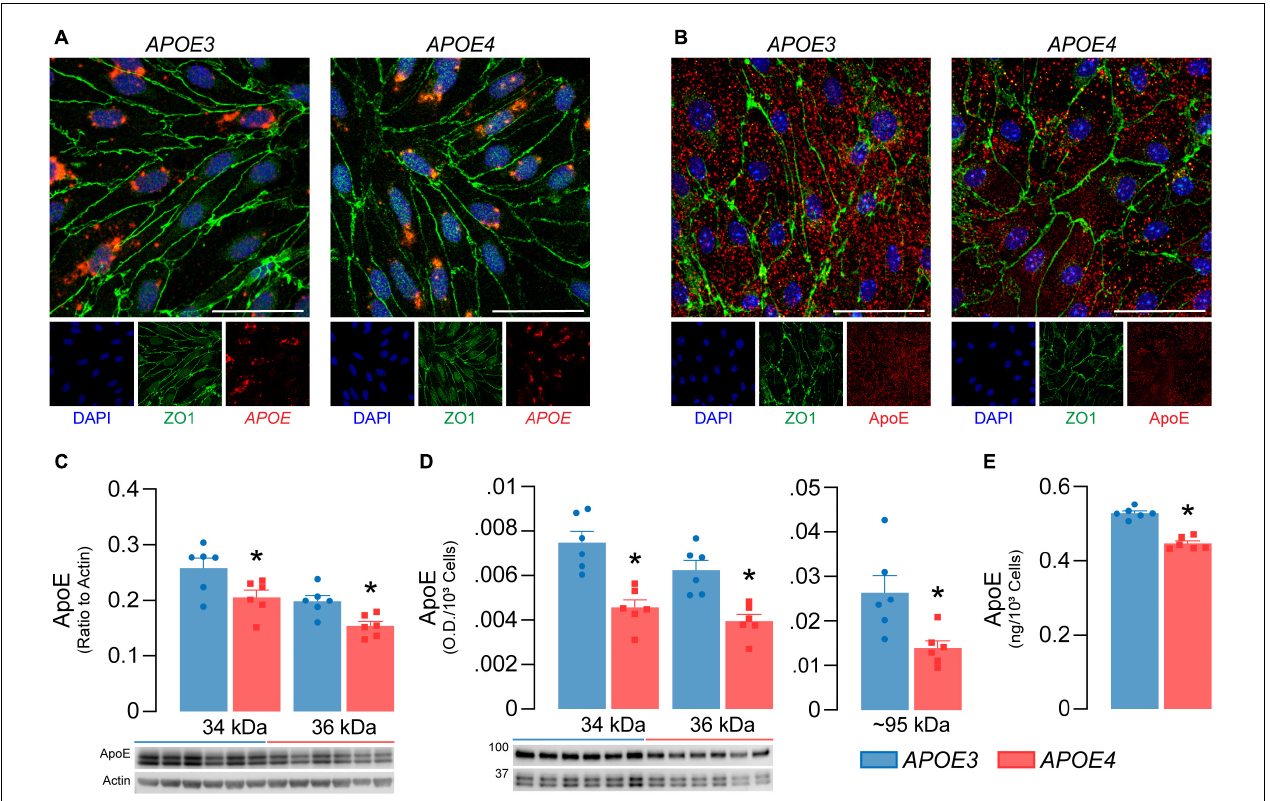
FIGURE 2 | APOE4 brain endothelial cells produce less apoE compared to APOE3 . APOE3 and APOE4 brain endothelial cells express (A) the APOE transcript (red) and (B) produce apoE protein (red) when assessed by in situ hybridization and immunocytochemistry, respectively. Cells were counterstained for the brain endothelial cell marker ZO1 (green) and DAPI (blue); representative confocal Z-stack images were captured at 52X (scale bar = 20 µ m). Both (C) cell-associated (lysate) and (D) secreted (conditioned media) apoE levels are lower with APOE4 when assessed by western blot analysis. Cell-associated apoE was normalized to actin as a loading control and secreted apoE was loaded as equal volumes and normalized to cell count. (E) ApoE levels in the media are ∼ 15% lower with APOE4 when quantified by ELISA and normalized to cell count. Data is expressed as mean ± S.E.M. * p < 0.05 by Student’s t -test, n =